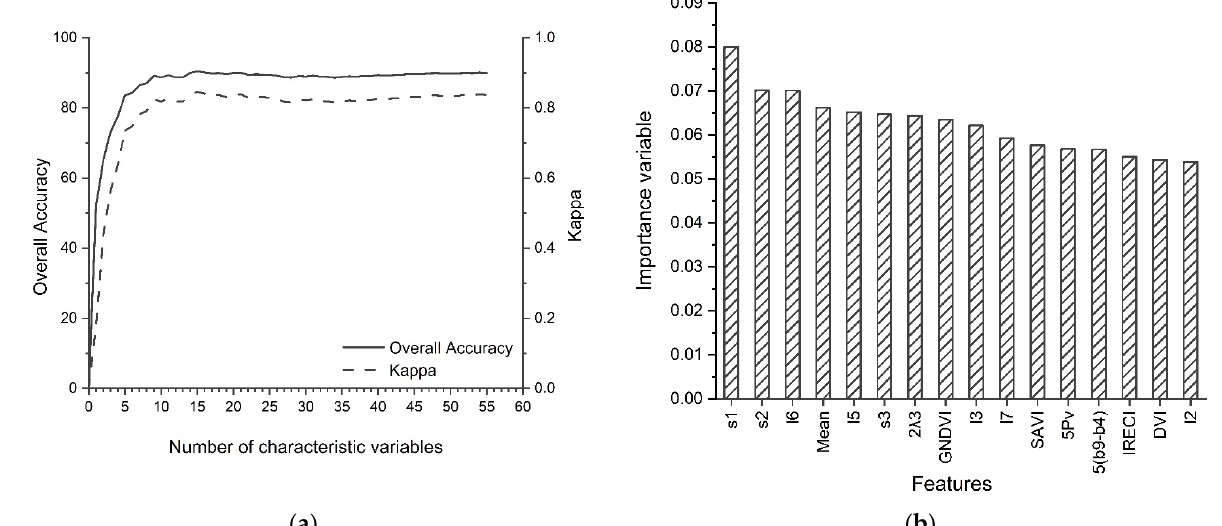
Figure 5. ( a ) The relationship between the number of features and the overall accuracy; ( b ) ranking the importance of preferred features (s1, s2 and s3 are the 1, 2 and 3 bands of Sentinel-2 satellite data, and l2, l3, l5, l6 and l7 are the 2, 3, 5, 6 and 7 bands of Landsat-9 satellite data) .